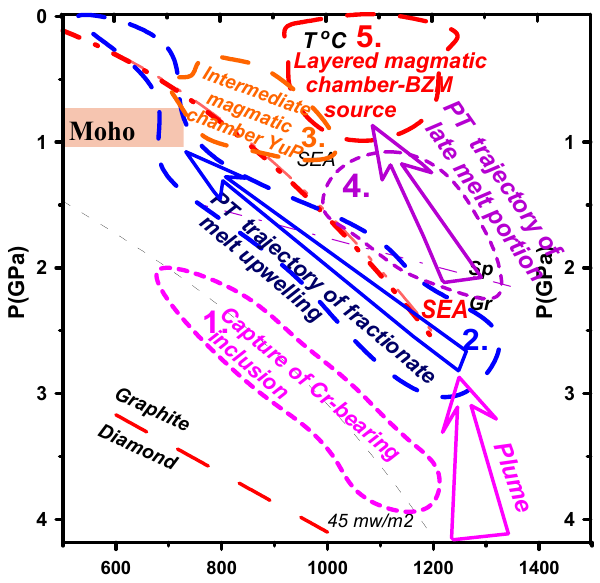
Figure 21. Scheme of PT evolution mantle melts according to thermobarmetry.